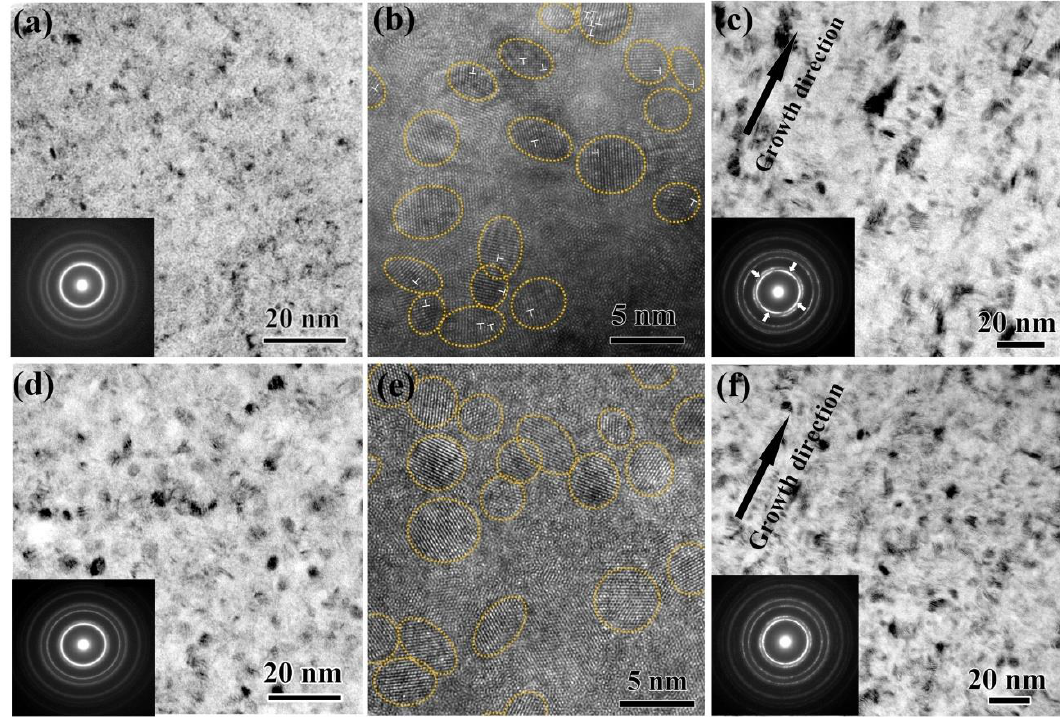
Figure 2. ( a , d ) planar bright field transmission electron microscope (TEM) images; ( b , e ) high resolution transmission electron microscopy (HRTEM) images and ( c , f ) bright field TEM images in growth direction of ( a – c ) as-deposited and ( d – f ) 325 ◦ C for 0.5 h annealed Ni-7.1%P alloy, respectively. Dislocations were marked with white ‘T’. Insets are the corresponding selected area diffraction pattern (SADPs). The inhomogeneous distribution of reflection ring intensity in (c) was marked with white arrows..